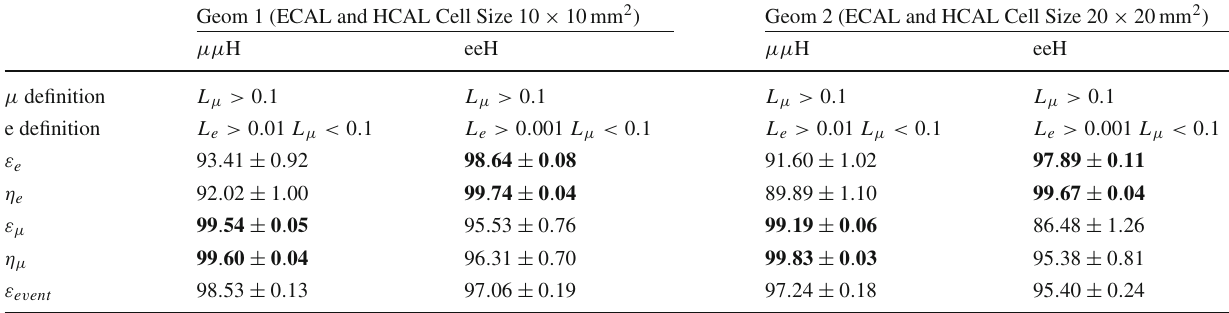
Fig. 12 e-likelihood and μ -likelihood of charged particles with E > 20GeV in μμ H event Table 3 μμ H/eeH events lepton identification